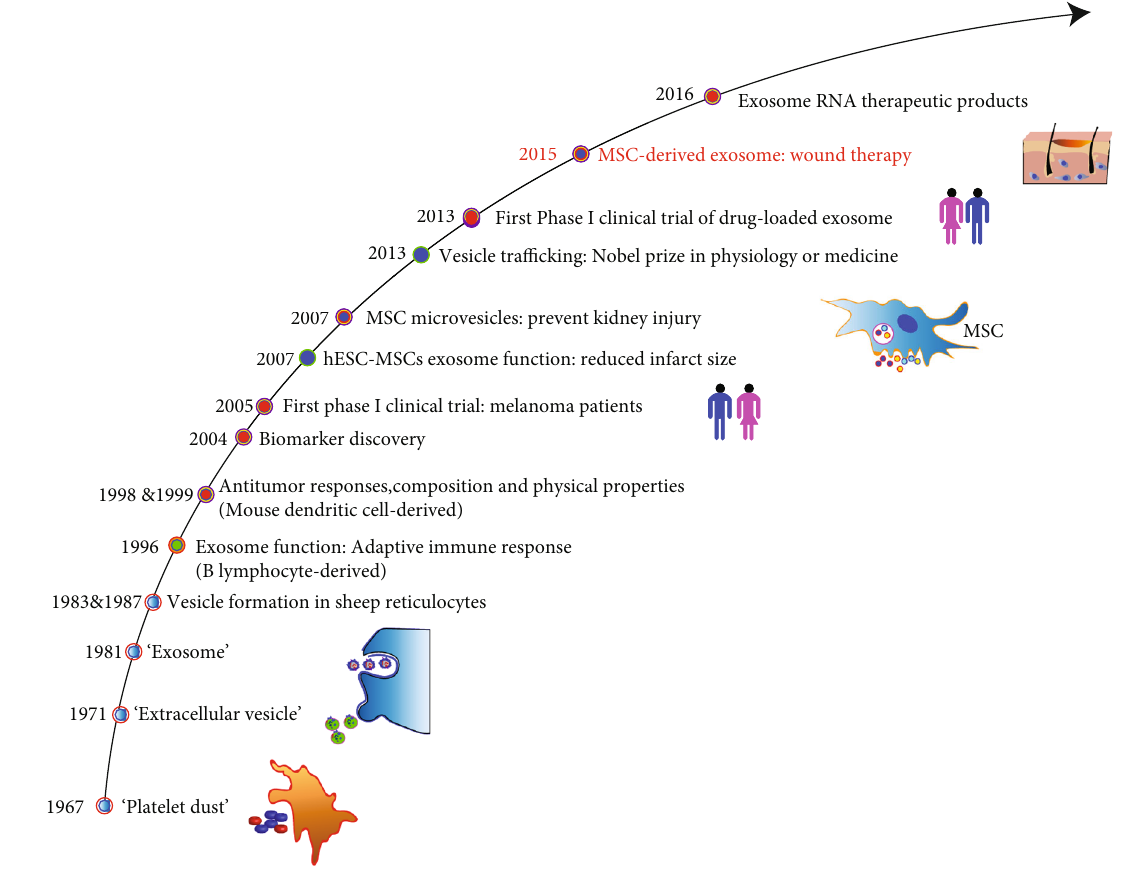
Figure 1: Timeline of the discovery and application of CDNs.